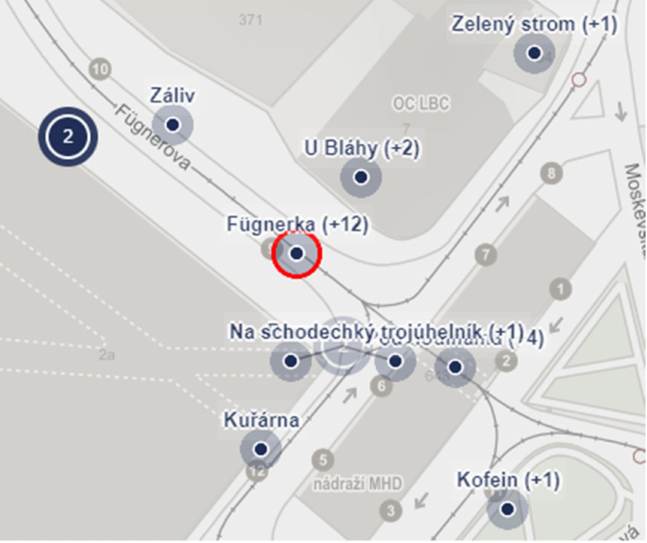
Figure 3. The suppressed map colors do not distract the respondents´ attention when reading the map. The clustering partially solves the problem of possible graphical conflicts between the objects. If objects are too close to each other, they appear with a guide line. The numbers next to the names show the numbers of other name variations. The selected object is highlighted with a red